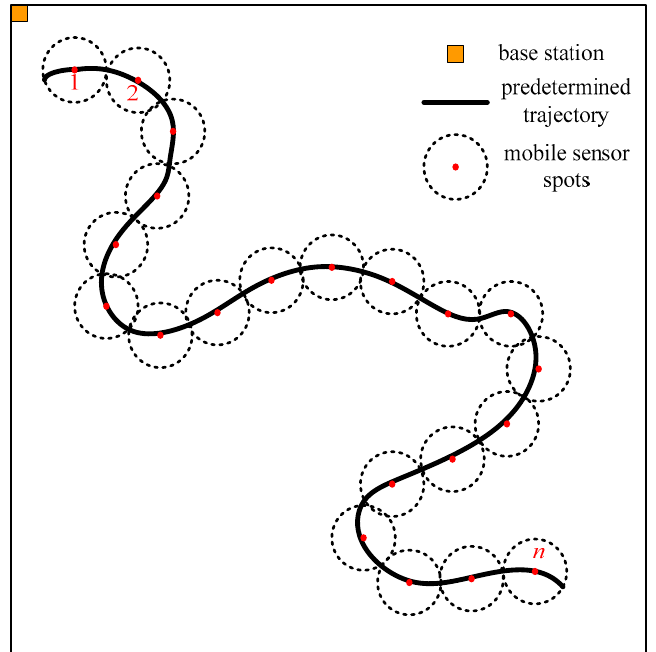
Figure 1. The movement trajectory of an object in the moving object coverage problem.